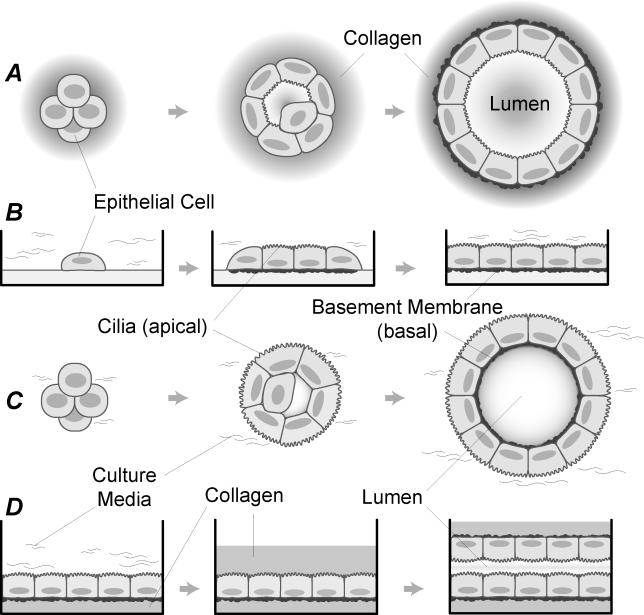
EC Growth Characteristics in Four Different In Vitro Culture Conditions (Cross-Section)For each culture condition, development typically starts with one or several ECs.(A) Cell division, apoptosis, and shape change over a period of several days in embedded culture often leads to a stable, lumen-containing cyst formed by a single layer of ECs.(B) ECs plated on a layer of collagen (surface culture) typically generate a stable, uniform monolayer.(C) Inverted cysts (cell polarity relative to that in (A) is inverted) form in suspension culture, with matrix deposited on the inside of the cyst.(D) Lumens are frequently formed in collagen overlay experiments.